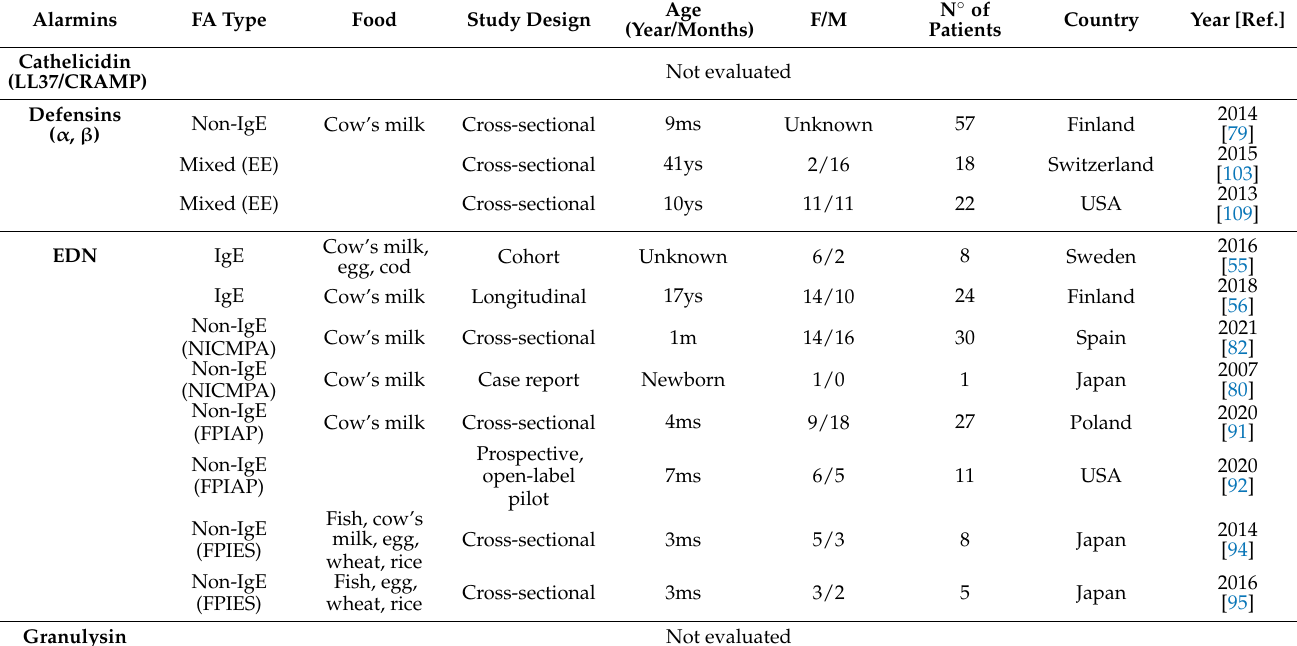
Table 2. Human studies on granule-derived alarmins in food allergy.